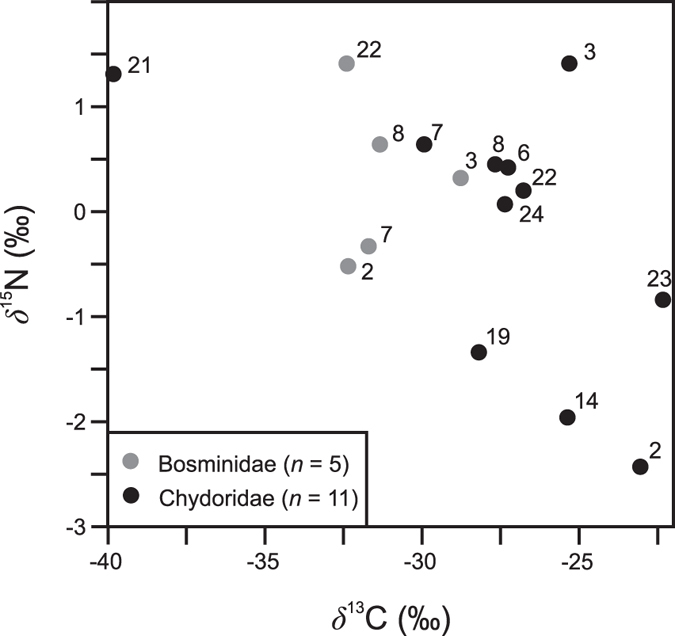
Stable isotopic composition (δ13C, δ15N) in benthic and planktonic Cladocera (Chydoridae, Bosminidae) in the surface sediments of lakes in northern Finland.